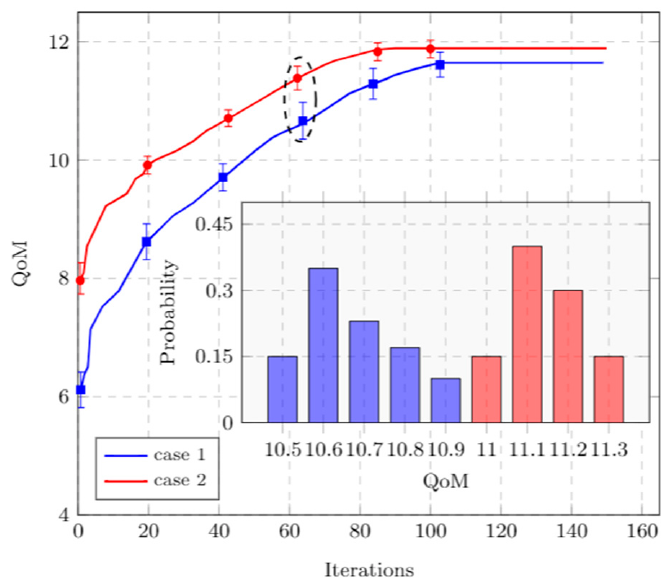
Figure 14. Convergence experiment.